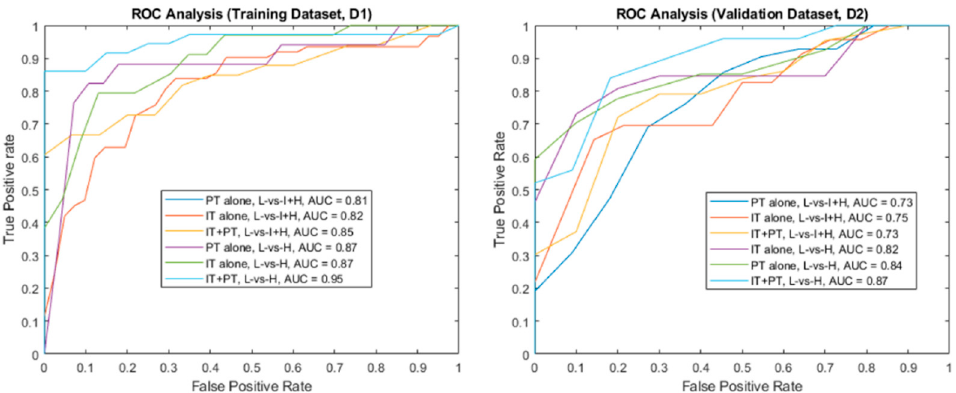
Figure 1. T2W MRI of a high risk and a low risk lesions ( left ) with their corresponding CoLlAGe entropy heat maps overlaid on the peri-tumoral (0–12 mm) regions ( right, inset).